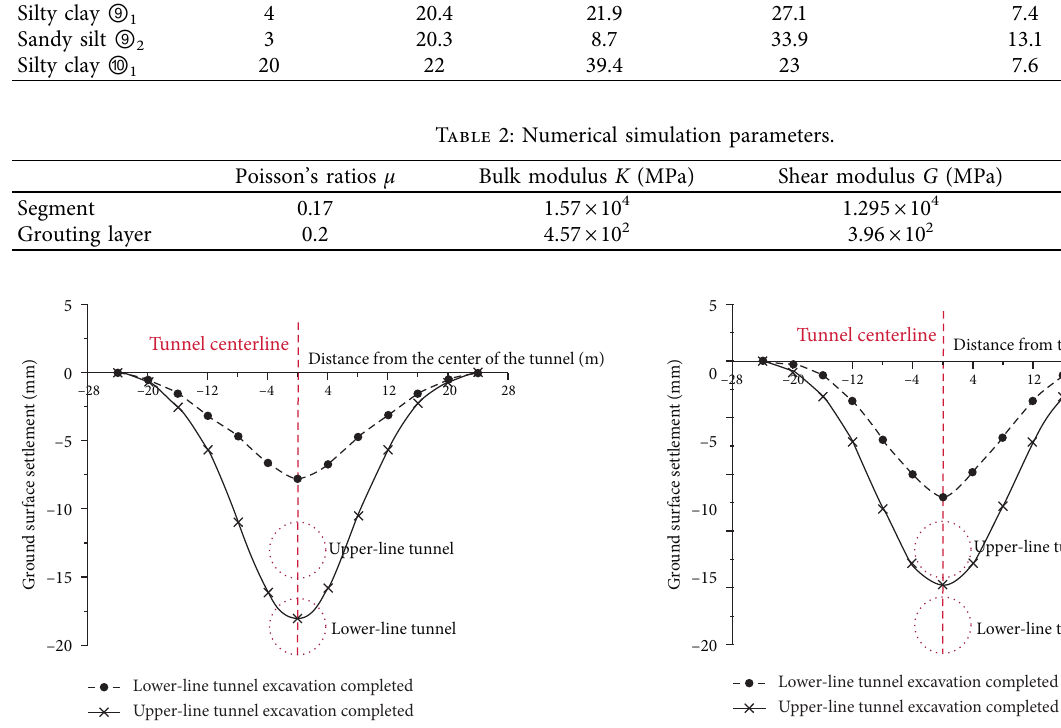
Figure 5: First down and then up construction sequence surface settlement curve.